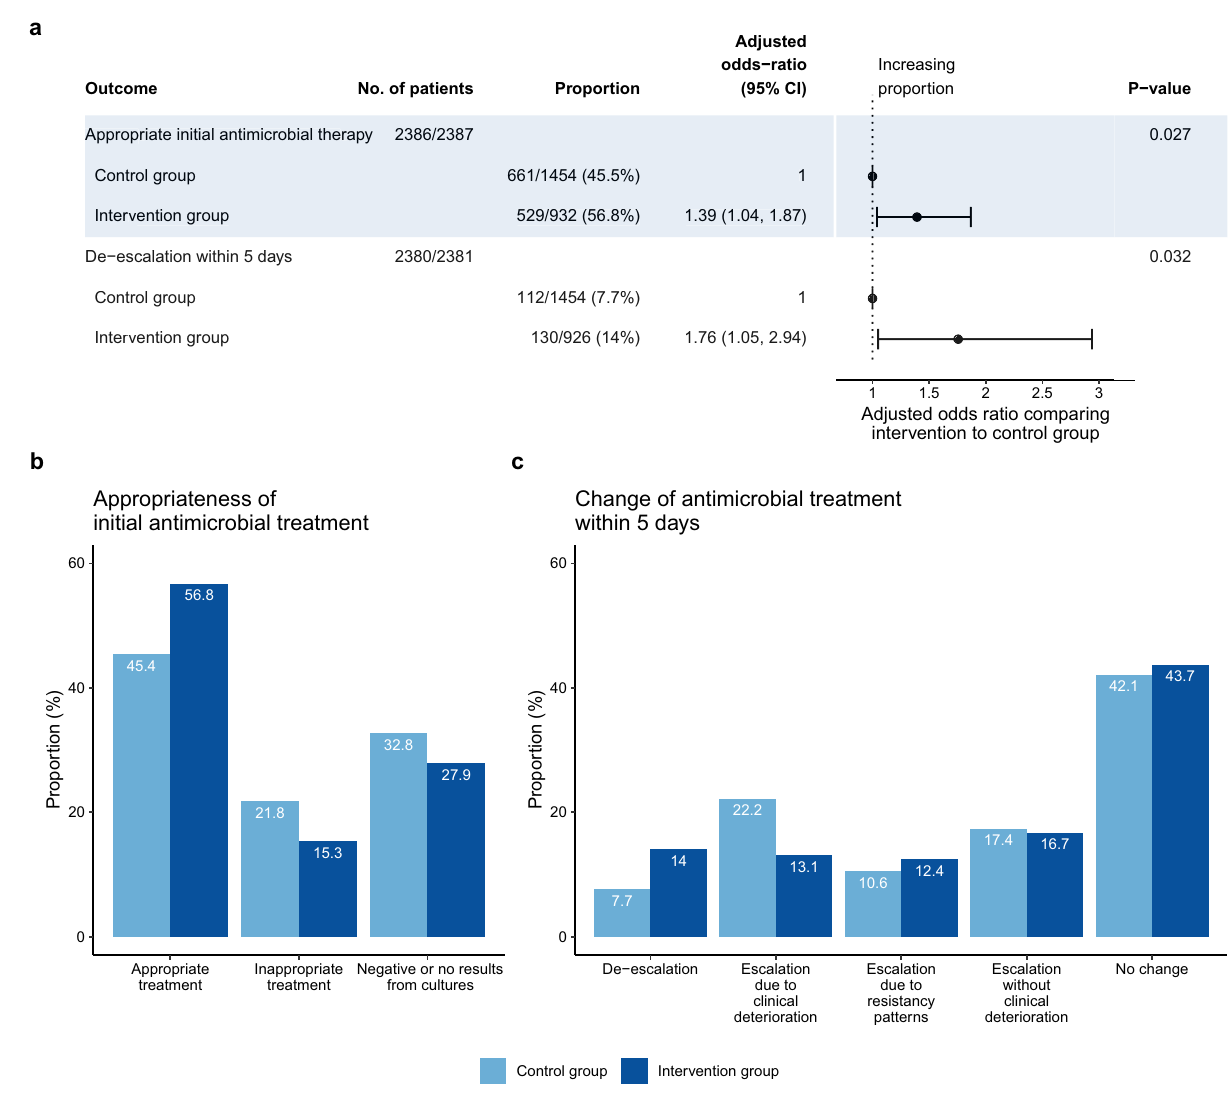
Figure 3. Comparison between groups during phase 2 of the trial regarding appropriateness and de-escalation of antimicrobial therapy. Analyses based on data of 29 participating hospitals. (a) Adjusted odds-ratios and p-values result from hierarchical generalized linear models with a logit link adjusted for the covariates age, sex, origin of infection, focus of infection, location at onset of infection and vasopressor use during the first 12 h. Since definitions of measures were changed between phases, no difference-in-difference analysis was possible. No. of patients gives the number of cases with complete data both on outcome and confounders compared to the total number of cases were the respective outcome was measured. Intraclass correlations (ICC): Appropriate initial antimicrobial therapy, ICC = 0.03; De-escalation within 5 days, ICC = 0.03. (b) Barplot on appropriateness of initial antimicrobial treatment. (c) Barplot on change of antimicrobial treatment within five days after sepsis